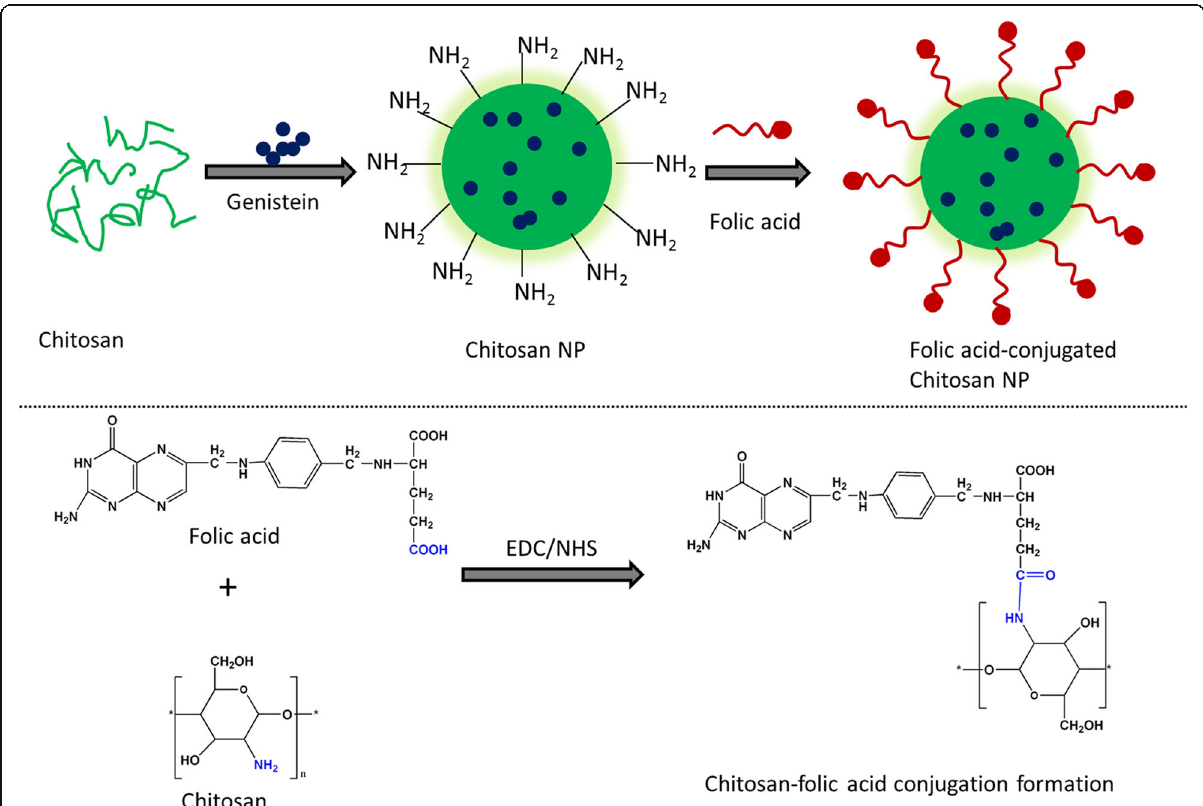
Fig. 1 Schematic illustration of preparation of Genistein-loaded folic acid-conjugated chitosan